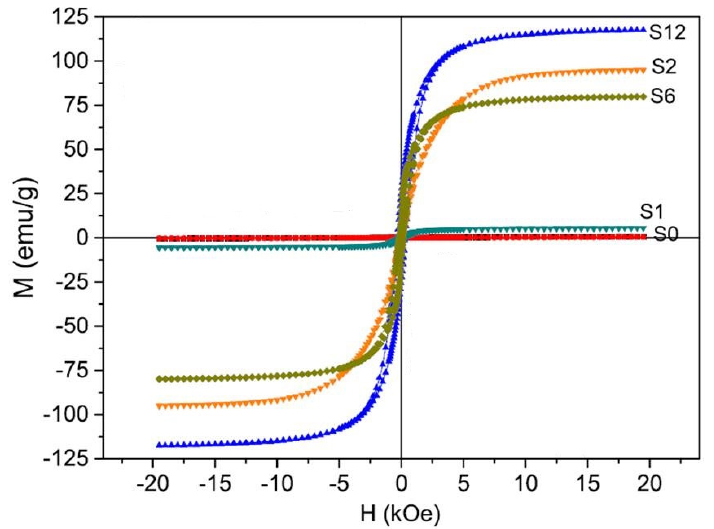
Figure 6. Magnetic hysteresis loop of Co/Al 2 O 3 nanocomposite after milling time (0 h (S0), 1 h (S1), 2 h (S2), 6 h (S6), and 12 h (S12)) [75]. (RightsLink Printable License obtained to use this Figure